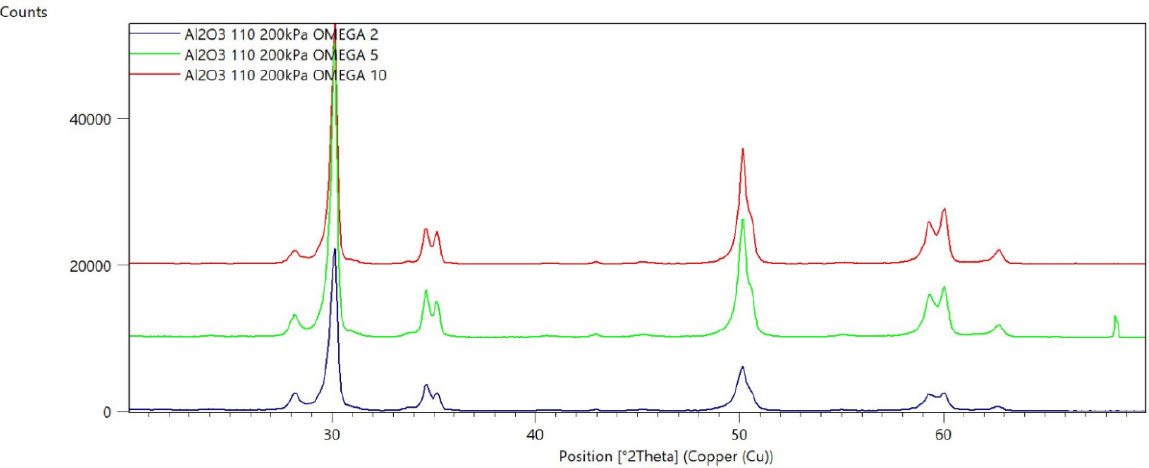
Figure 3. Diffraction patterns of sample B (abrasive—Al 2 O 3 60 μ m, pressure 400 kPa).